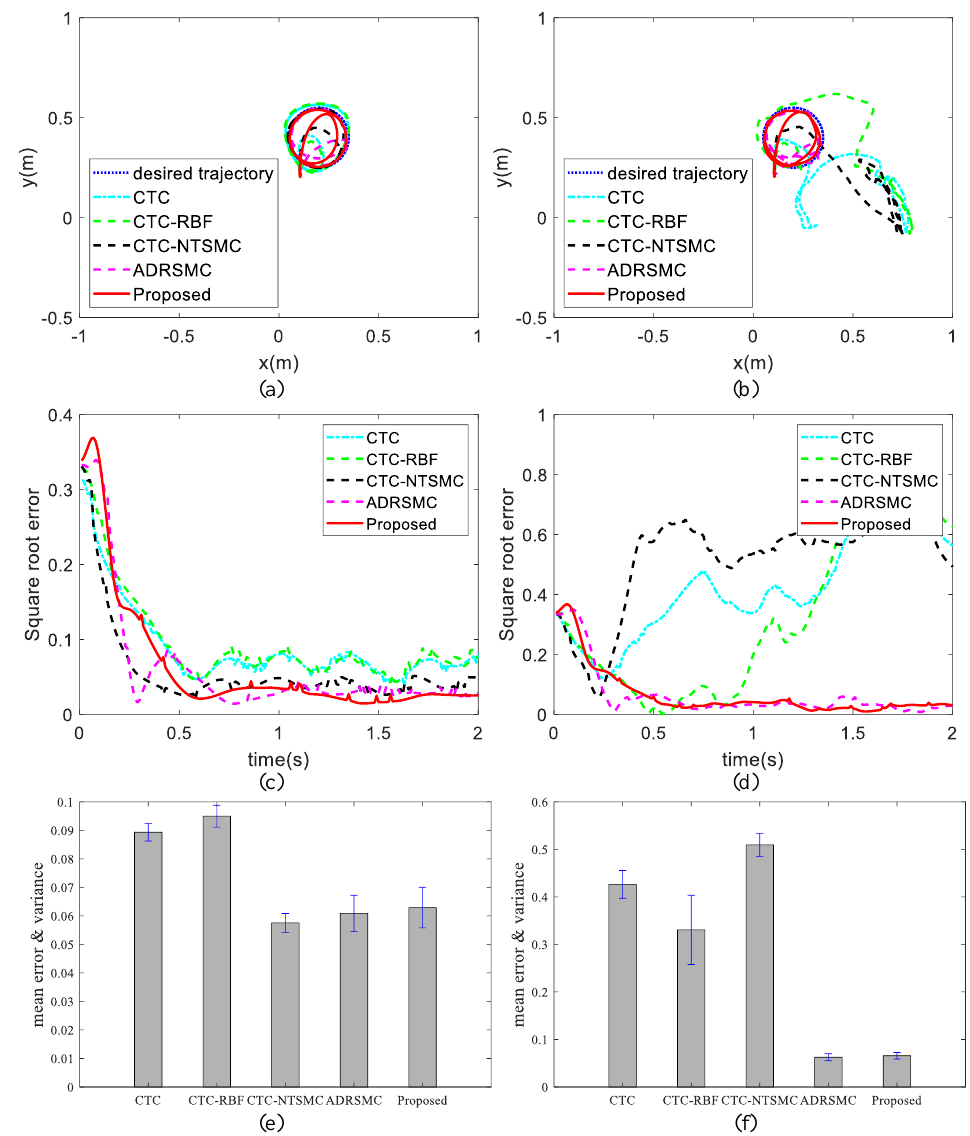
Figure 6. Comparison results of uniform trajectory tracking. ( a ) end motion trajectories without the addition of joint measurement noises, ( b ) end motion trajectories with the addition of joint mea- surement noises, ( c ) square root errors without the addition of joint measurement noises, ( d ) square root errors with the addition of joint measurement noises, ( e ) mean errors and variances without the addition of joint measurement noises, ( f ) mean errors and variances with the addition of joint measurement